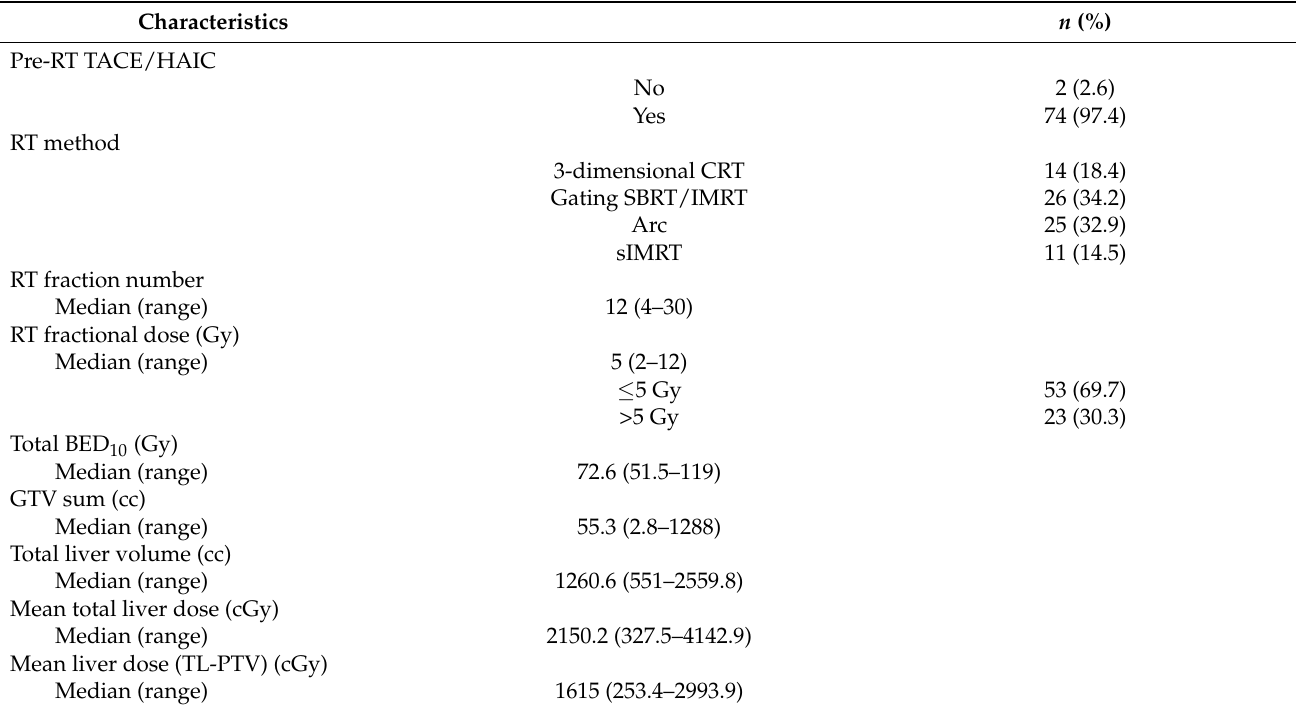
Table 2. Treatment